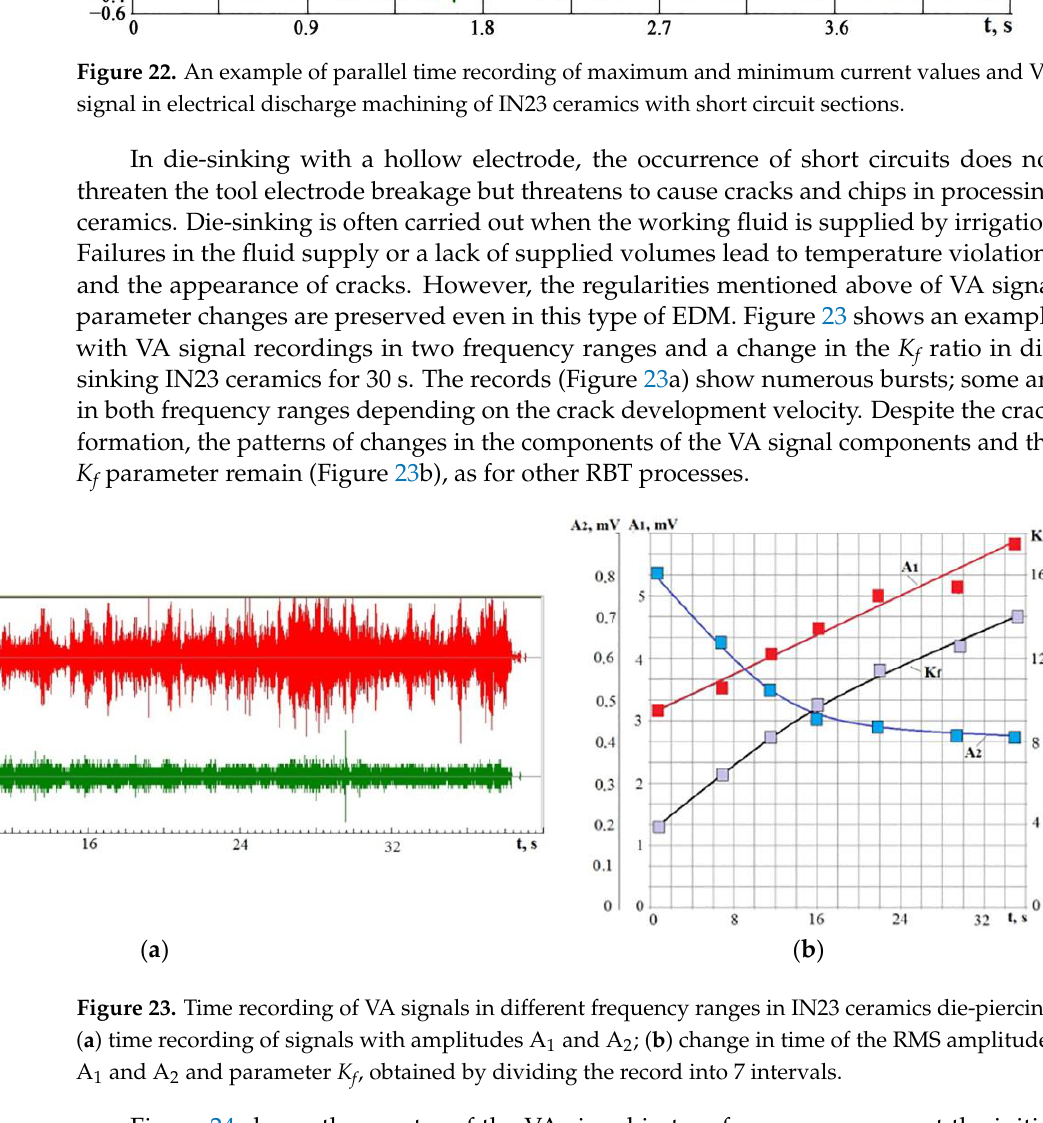
Figure 22. An example of parallel time recording of maximum and minimum current values and VA signal in electrical discharge machining of IN23 ceramics with short circuit sections.